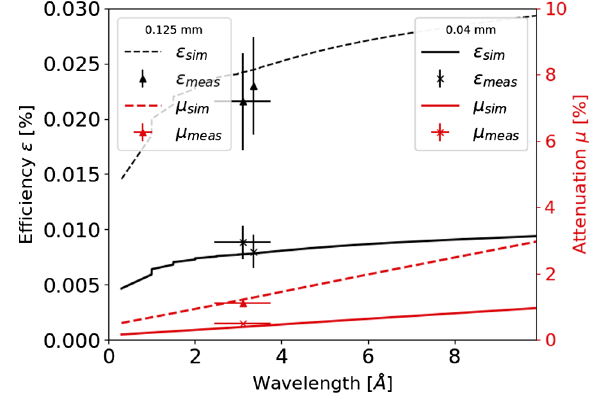
FIG. 13. Efficiency and attenuation of the beam monitor prototype. The figure shows the simulated and measured attenu- ation and efficiency for two of the foils: 0.125 mm (dashed lines, 12. Absolutely calibrated counts from the wavelength triangle marker) and 0.04 mm (solid lines, cross marker). The left band at V20. The x-axis shows the ϕ , the absolute beam absolute axis (black) displays the measured efficiency ( ϵ m ) and the intensity measured and corrected by the absolutely calibrated 3 He simulated efficiency ( ϵ s ) while the right axis (red) displays Eurisys Mesures detector. The y axis shows the measured values the measured attenuation ( μ m ) and the simulated attenuation corrected by the results of simulations for each ( μ s ). The uncertainties in x direction at V20 at 3.1 Å were determined from the FWHM of the reference 3 He beam monitor.